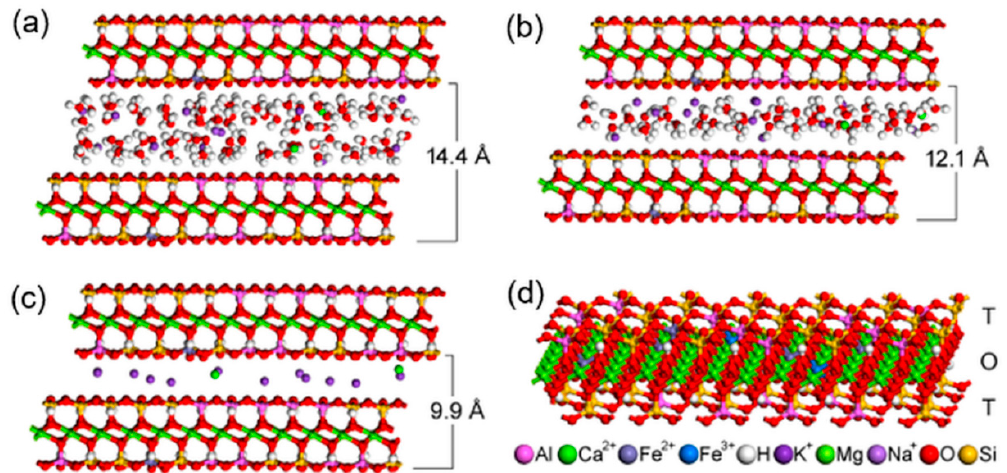
Figure 4. Four models of vermiculite interlayer space arrangement: ( a ) corresponding to the basal distance c = 14.4 Å; ( b ) corresponding to the basal distance c = 12.1 Å; ( c ) corresponding to the basal distance c = 9.9 Å in vermiculite thermally treated at 500 °C and 700 °C; ( d ) Model of a single 2:1 layer showing the positions of atoms in the tetrahedral (T) and octahedral (O) sheets. The color legend for all atoms occurring in the models is below the image. Table 2. Total potential energies (E tot ) and binding energies (E b ) for optimized α -Fe 2 O 3 /vermiculite models. Energies are expressed in kcal/mol.